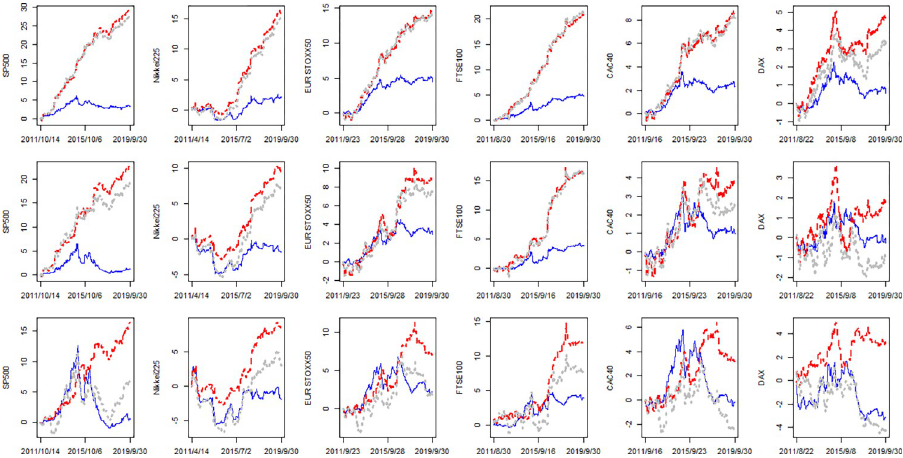
Fig 2. The cumSFE of LHARO, LHARV and LHAROV relative to LHAR. Notes: The first, second, third and row corresponding to h = 5,10,22, respectively. The blue line, red line and gray line denotes the cumSFE( LHARO , N ), cumSFE( LHARV , N ) and cumSFE( LHAROV , N ), respectively.